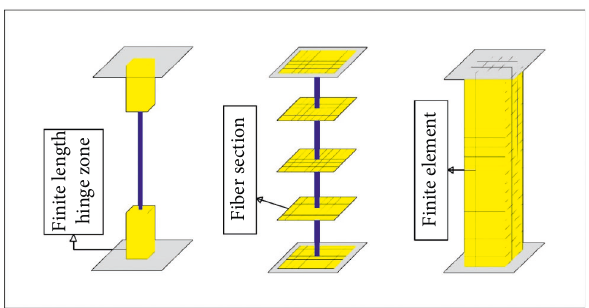
Figure 5: Distributed plasticity